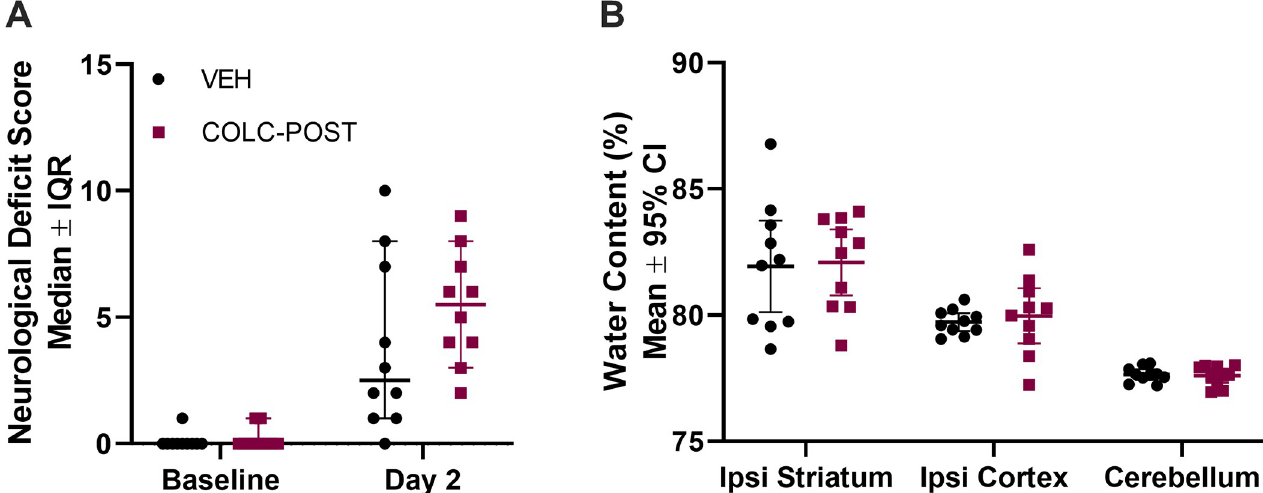
Fig 4. Experiment 3 edema and behaviour. ICH significantly worsened NDS scores at 48 hours post-ICH (A, p < 0.001), but no differences between groups were found (p = 0.169). Brain water content at 48 hours post-stroke (B) was significantly increased in the ipsilateral striatum (p < 0.001), but did not differ between groups (p = 0.412). n =